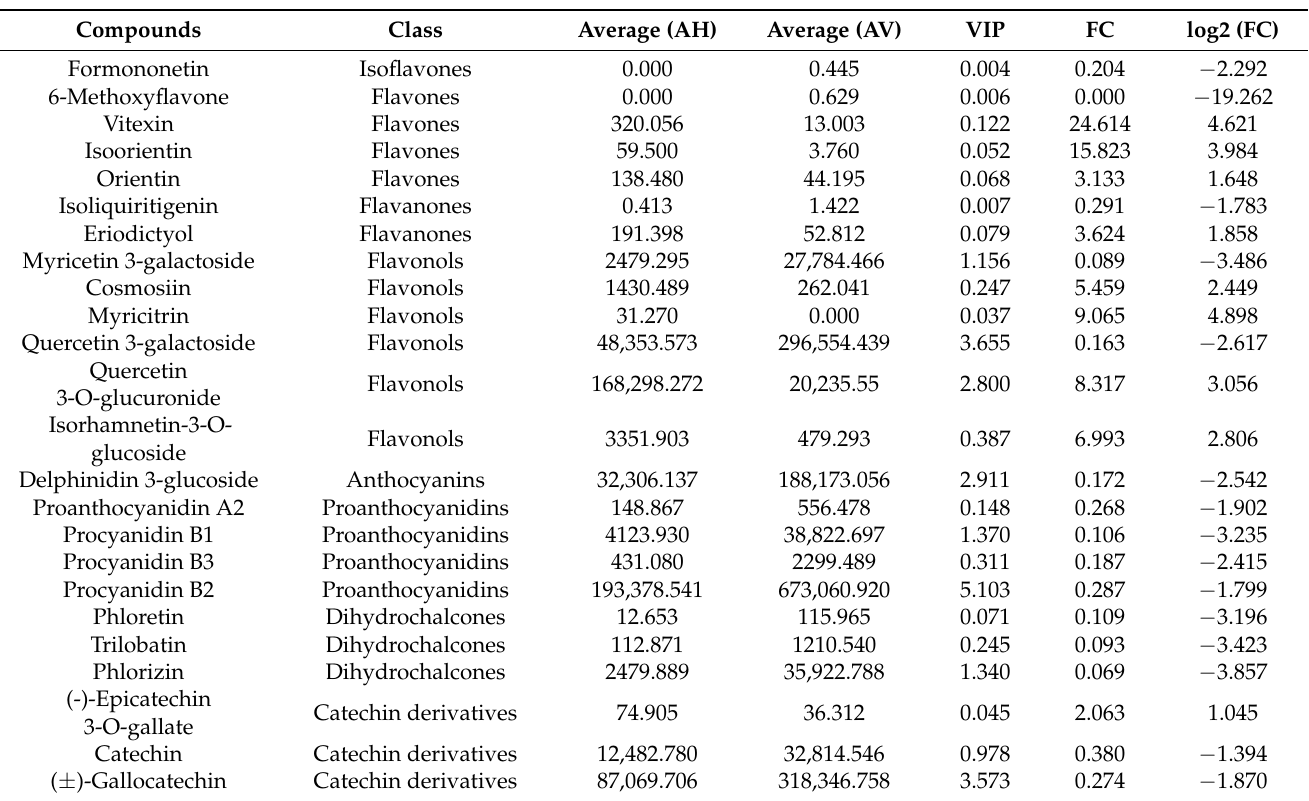
Table 2. A list of differential metabolites between A. venetum and A. hendersonii